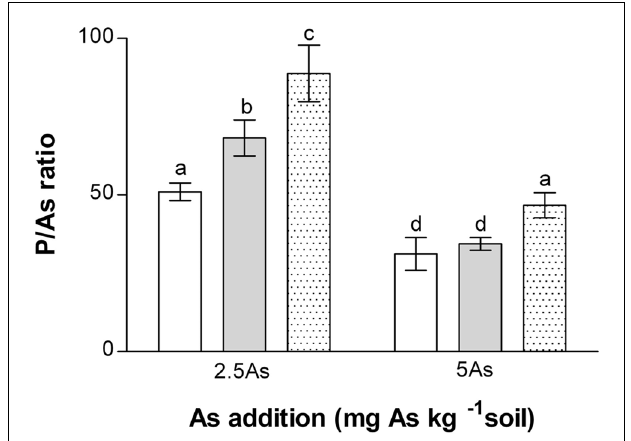
FIGURE 4 | Effect ofAs andinoculation on the molar P/As ratio of non-mycorrhizal (open bars) and mycorrhizal ( G. intraradices , gray bars and G. mosseae , dotted bars) medic ( Medicago truncatula ) grown in pots with different phosphorus (P) levels, 10 and 20mgPkg − 1 soil (LP and HP, respectively) and with no arsenic (As) added to the soil (0 As) or at rates of 2.5 and 5mgAskg − 1 soil (2.5As and 5As, respectively). No As was detectable in plants grown in the absence of As, and these treatment groups were therefore excluded from analysis. Data are presented as mean values ± SEM ( n = 10, except for treatment group NM, 5 As where n = 8).The interaction between As and inoculation was significant ( P = 0.015) and independent of the effect of P ( P = 0.044). Same letters indicate no significant difference between treatment groups at the 5% level.